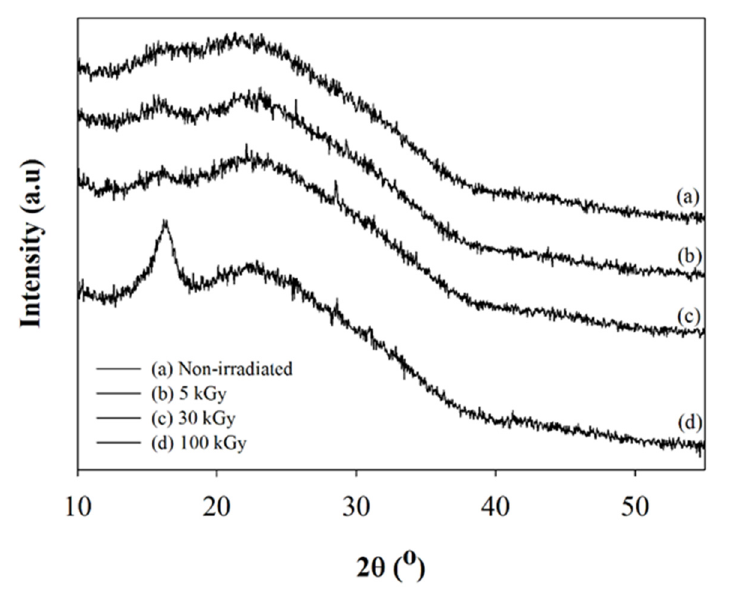
Figure 7. XRD di ff ractogram for PLLA / CMS / β -TCP composite nanofibers at di ff erent irradiation doses Figure 7. XRD diffractogram for PLLA/CMS/ β -TCP composite nanofibers at different irradiation measured by doses measured by DSC.